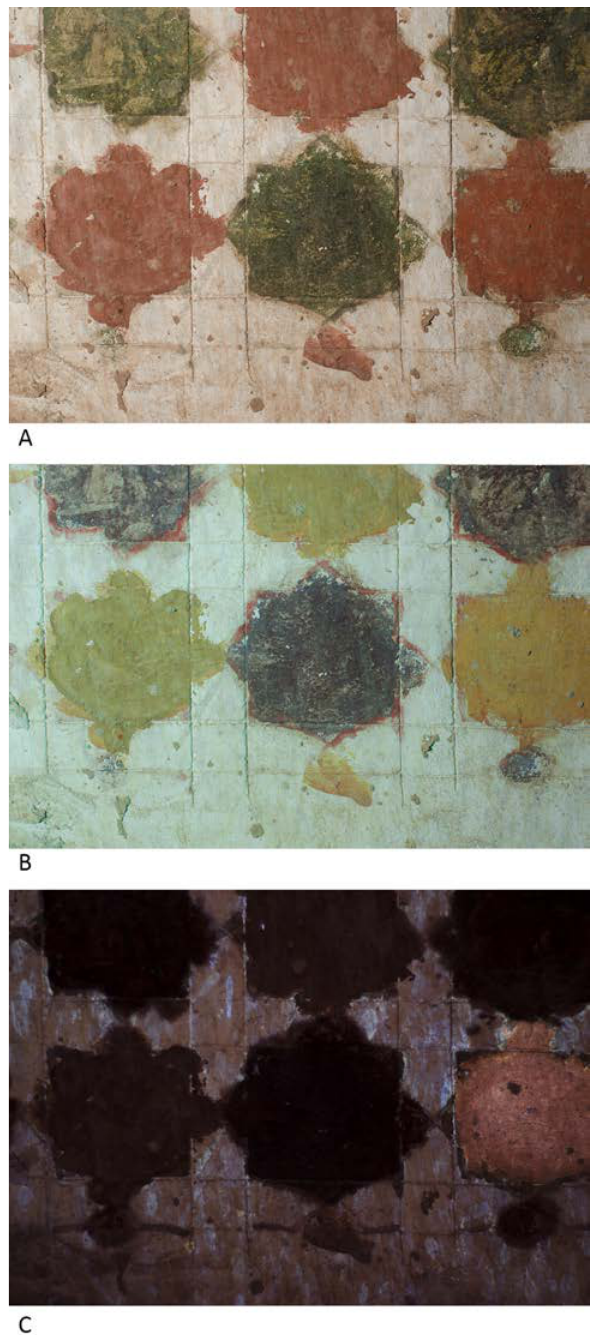
Figure 3: Non-invasive imaging. I mage A visible reflected image. Image B IR false colour image. Image C is the UV- induced visible fluorescence